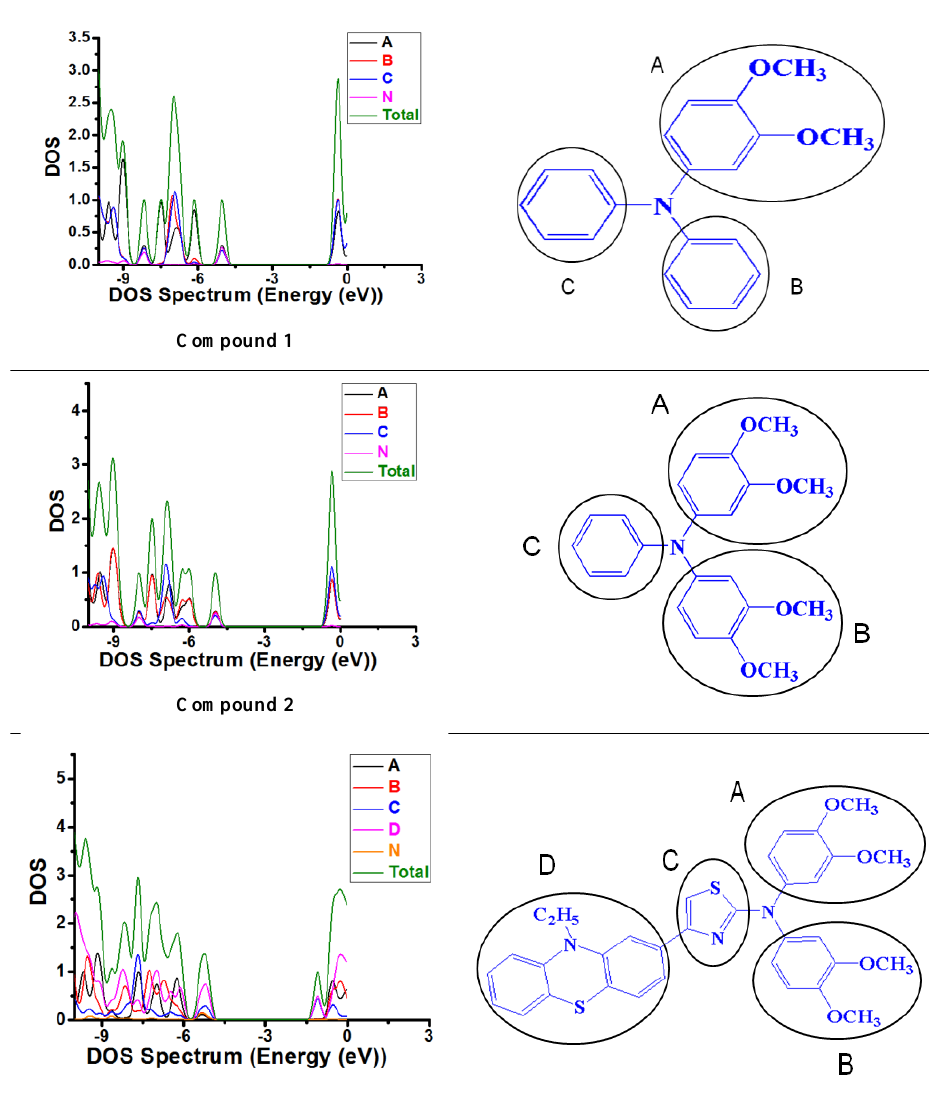
Figure 7. Partial density of states graphs of three compounds.